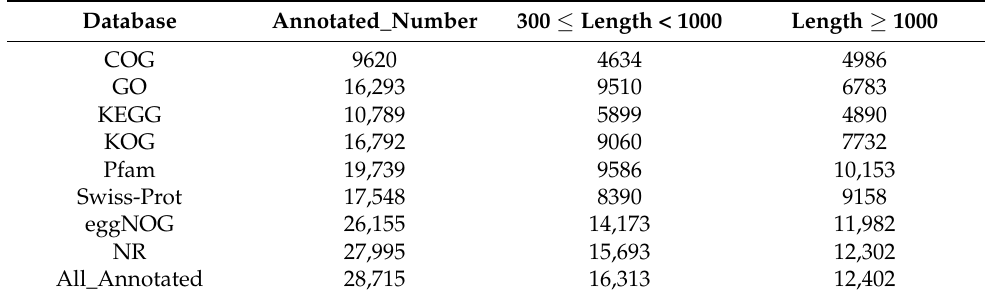
Table 2. Unigene functional